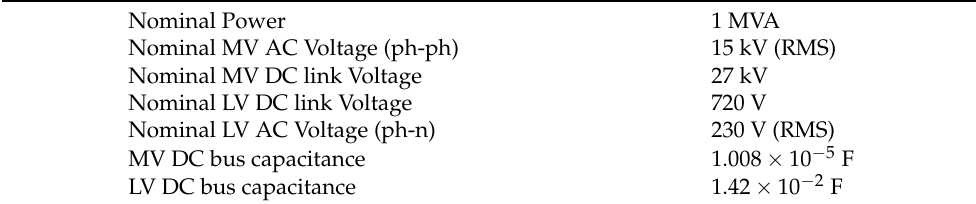
Table 2. Smart Transformer: Main parameters.